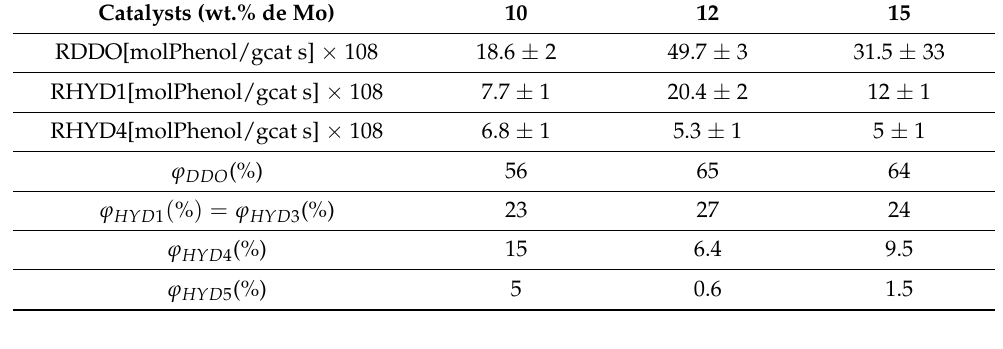
Table 5. Contribution factors for phenol HDO products in CoMoS/AT2 catalysts with Mo loadings of 10, 12 and 15 wt.%. Operating conditions: 320 ◦ C and 5.5 MPa. Catalysts (wt.% de Mo)